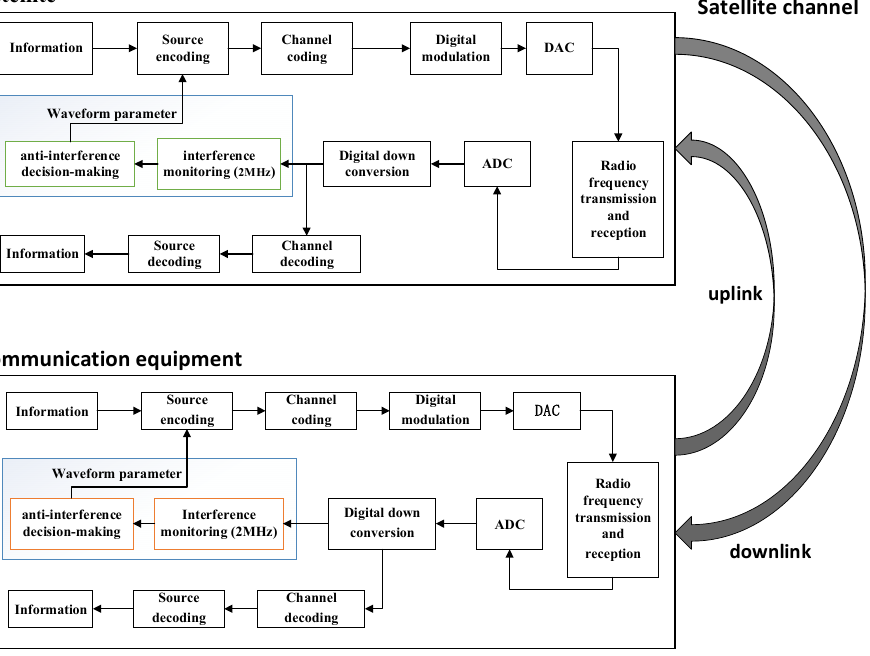
Figure 1. Composition of anti-interference communication